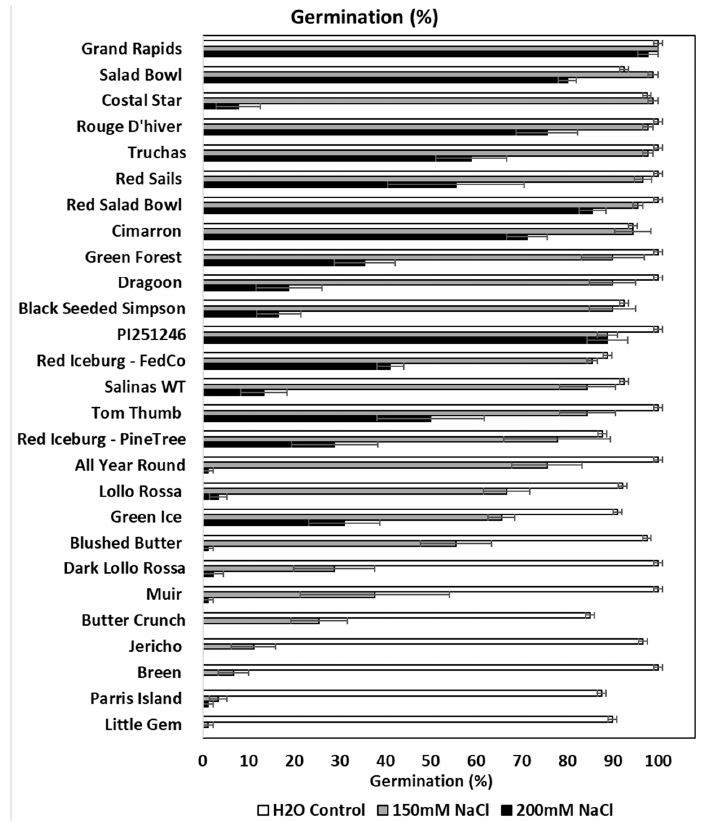
Figure 1. Germination sensitivity of 27 lettuce varieties to salt stresses. Seeds of 27 lettuce varieties were imbibed in H 2 O, 150 mM NaCl, or 200 mM NaCl solution for nine days in 16 h light/8 h dark at 20 °C.